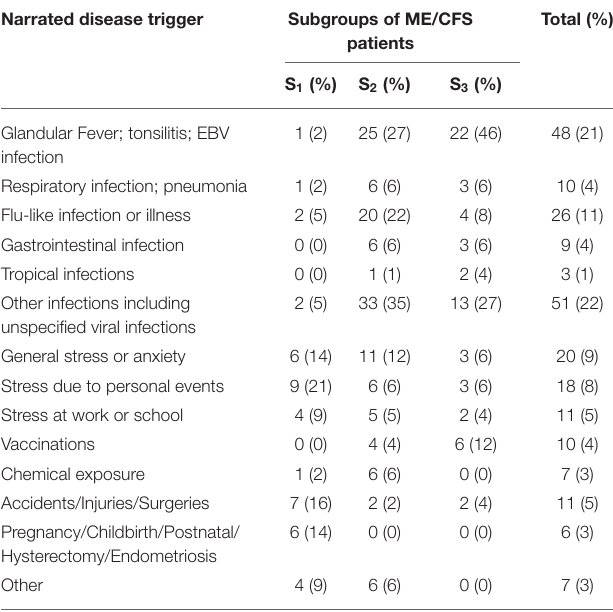
TABLE 2 | Frequency and the respective percentage within brackets of specific disease factors or triggers narrated by patients from the subgroups S 1 ( n = 43), S 2 ( n = 93), and S 3 , ( n = 48) in the participant’s questionnaire. Narrated disease